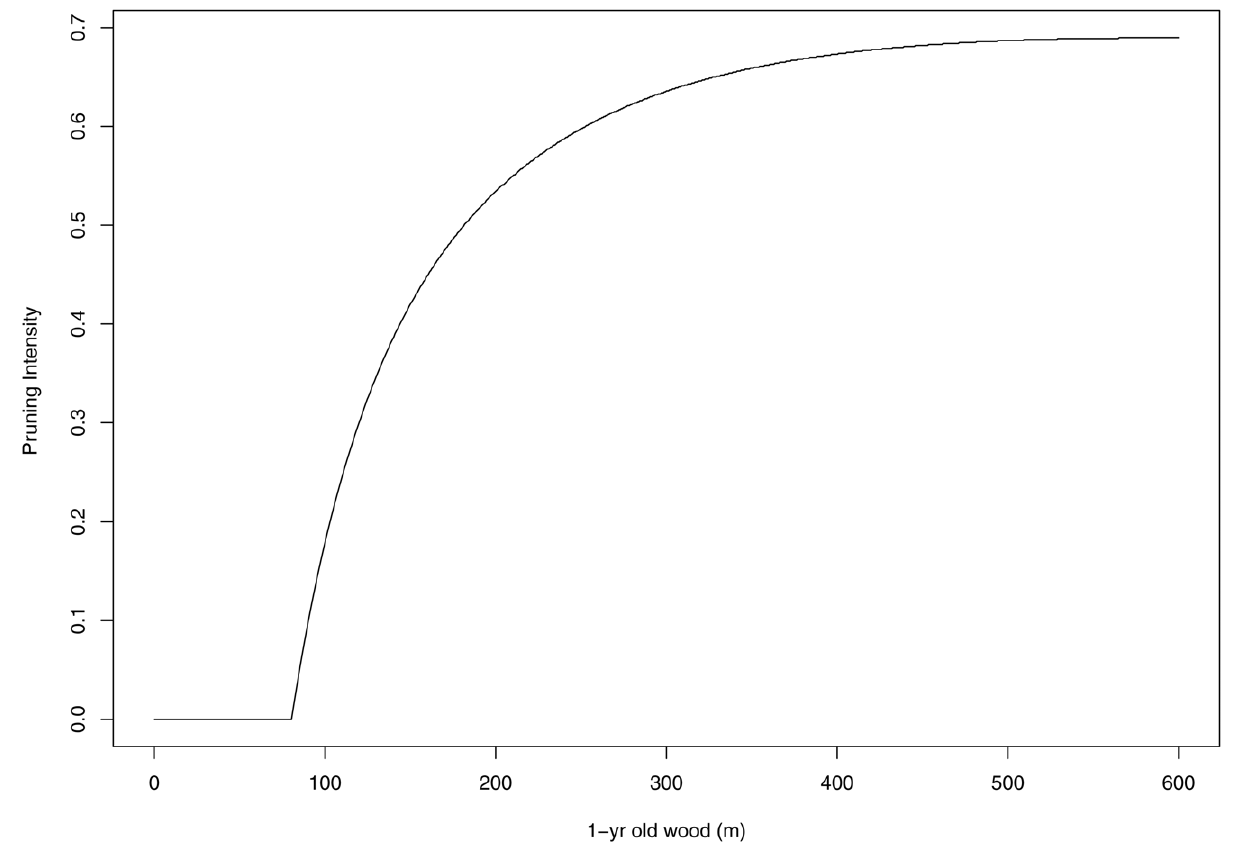
Figure 3. Pruning intensity (PI, i.e. ratio of 1-yr old shoot removed before bud break) determining the highest number of long shoots, as a function of 1-yr old wood before pruning (L w1 ). Figure S2 Variability of estimated parameters assessed via bootstrap (1000 iterations): bivariate scatter plots, linear fits and median values below and above the diagonal; histograms on the diagonal. Pearson correlation are equal to 2 0.89 0.49 and 2 0.80 respectively between log a – c , a – e , and c – e . (DOC) Text S1 Mathematical details.